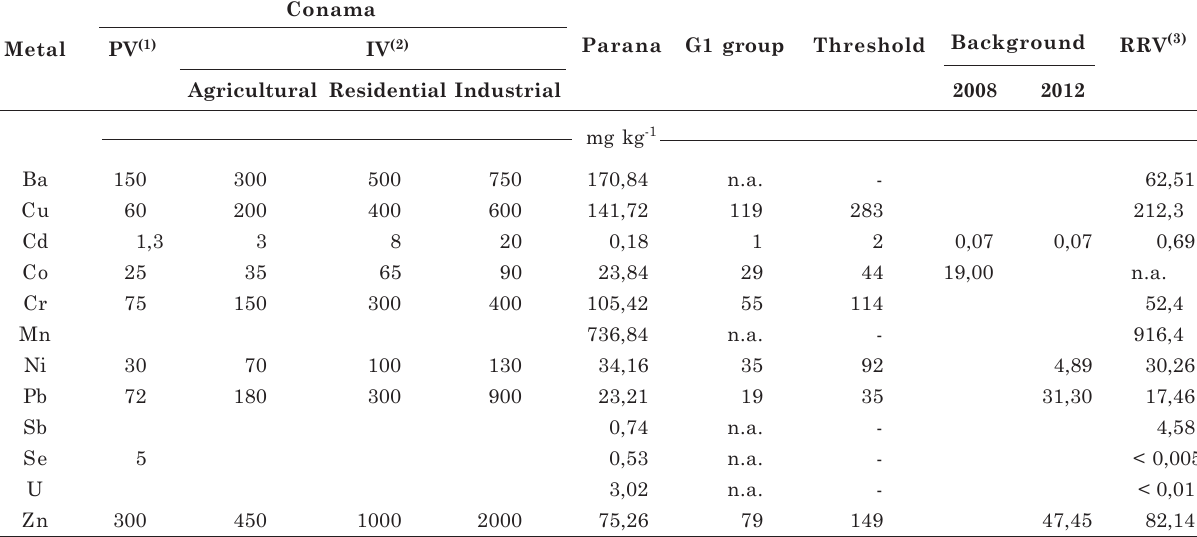
Table 5. Elements-trace concentration recommended by Conama, Paraná average values, G1 and their thresholds, background and